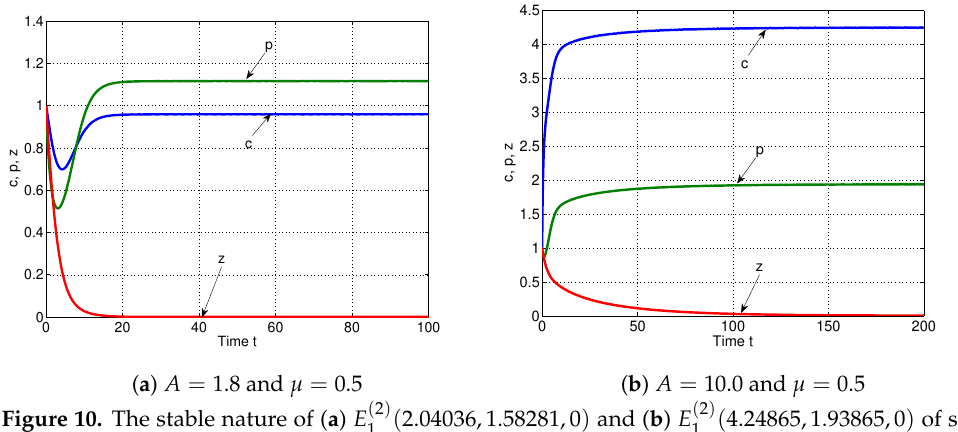
Figure 10. The stable nature of ( a ) E tem (1) when the remaining parameters are same as in Figure 6. Initial conditions: c ( 0 ) = p ( 0 ) = z ( 0 ) =